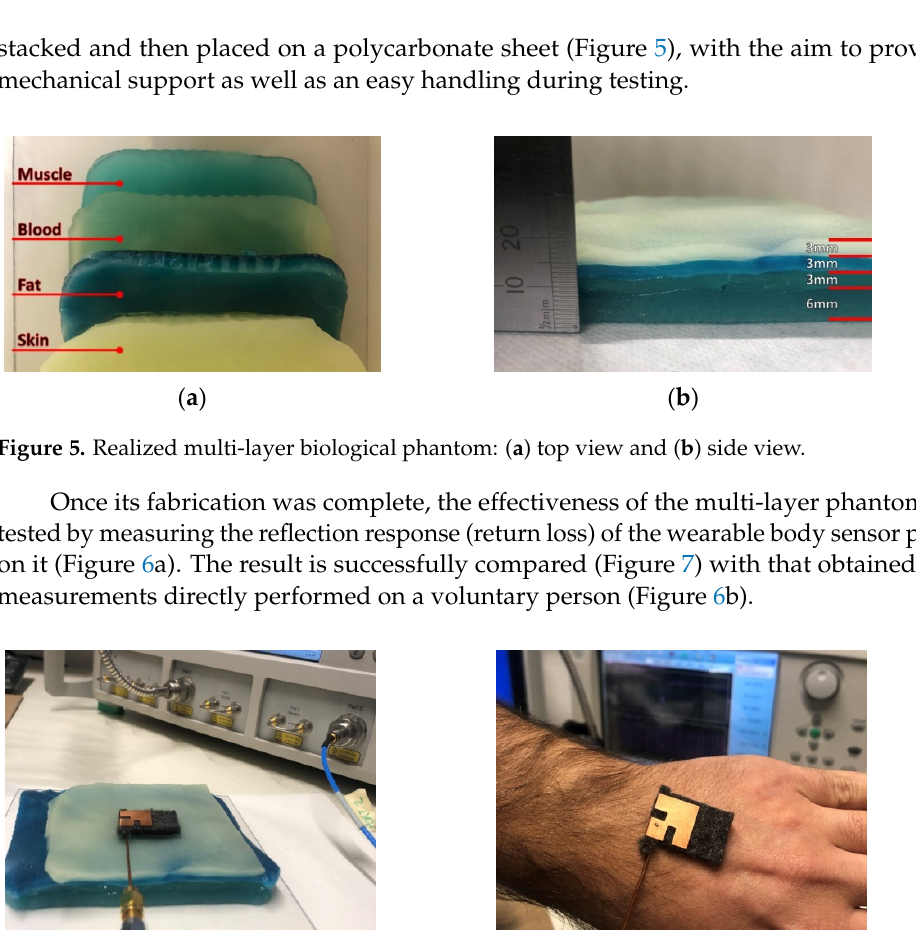
6 of 8 Table 3. Measured and reference dielectric parameters at 2.4 GHz. Phantom Type Measured ε′